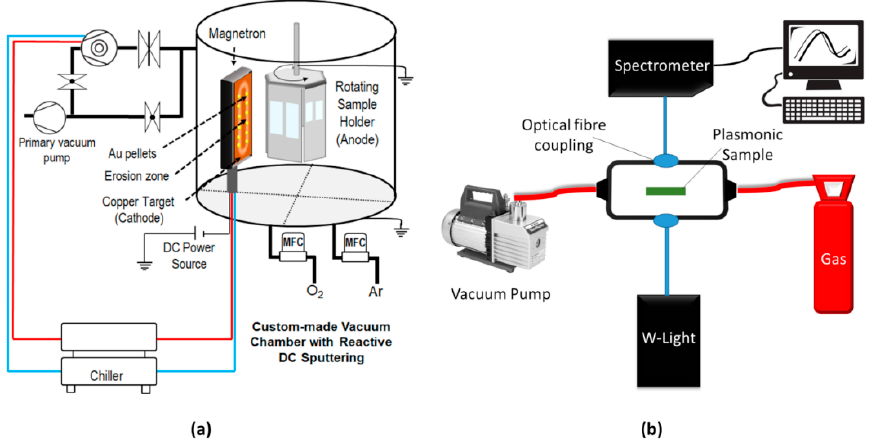
Figure 1. Simplified representation of the reactive DC magnetron sputtering system ( a ) and the custom-made system for transmittance-LSPR (T-LSPR) measurement in a controlled atmosphere ( b